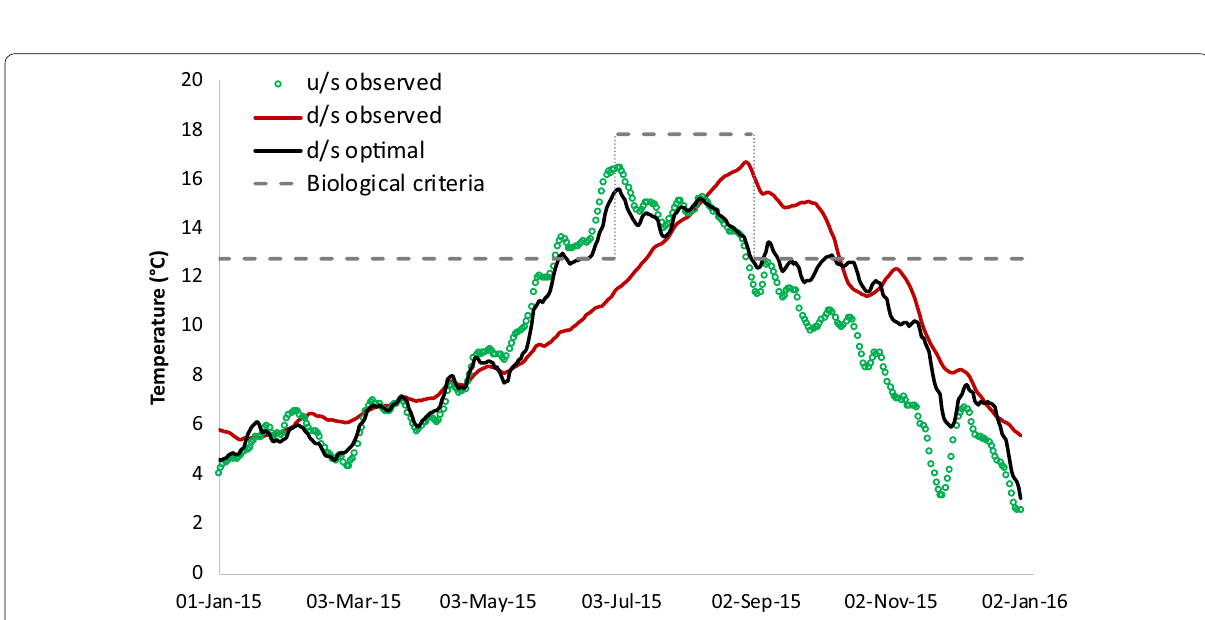
Fig. 13 Optimal downstream temperatures during the year 2015 based on the adaptive release policy for Detroit dam. The policy was able to contain downstream temperatures within the required biological criteria to meet spawning and rearing uses, in contrast to the observed scenario exceeding the